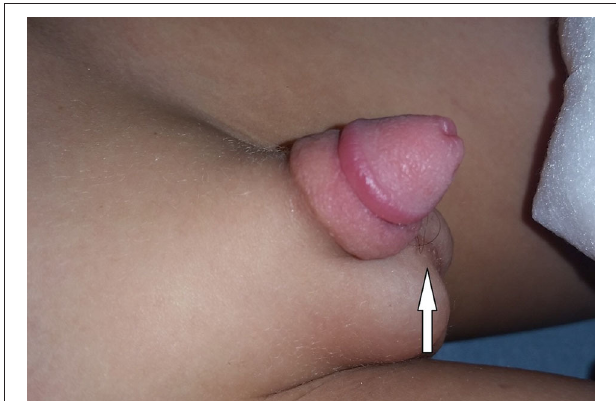
FIGURE 1 | Hair tourniquet with penile edema.